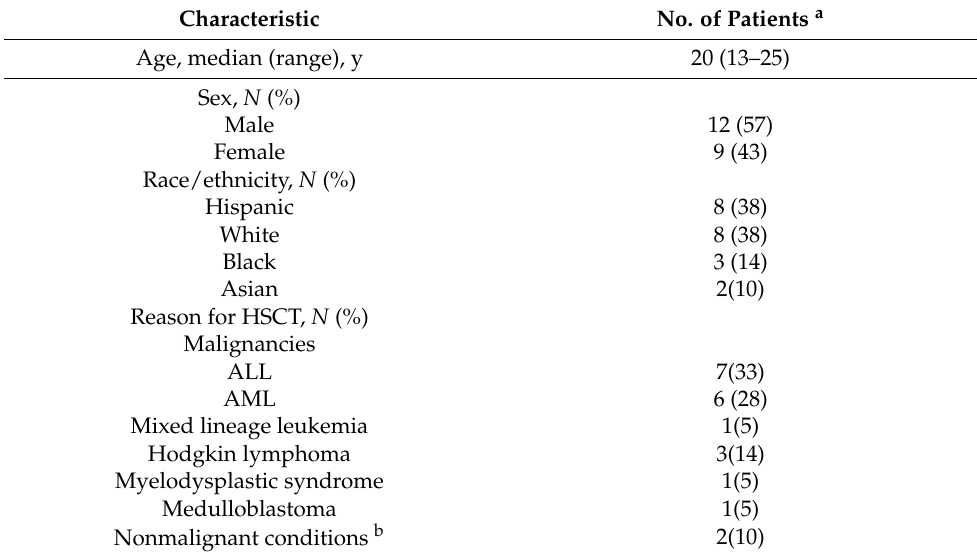
Table 3. Demographic and clinical characteristics of patients who submitted an MDASI-Adolescent (MDAS-Adol) ( N = 21).